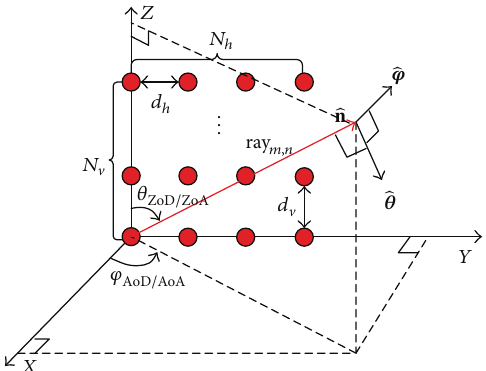
Figure 1: The coordinate system of 3D MIMO and the antenna configuration in the